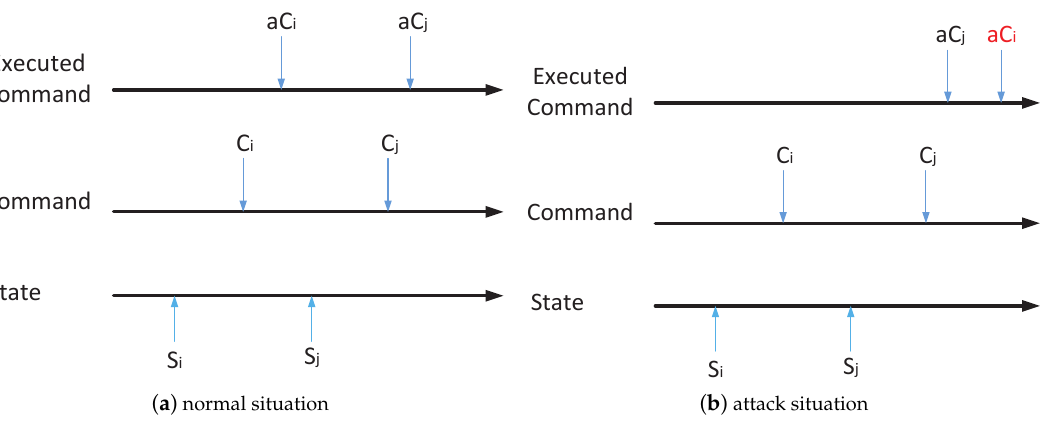
Figure 5. An example of the normal situation ( a ) vs. attack situation ( b